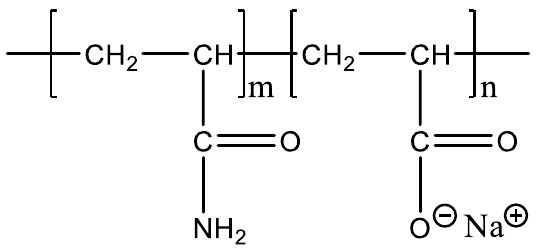
Figure 1. The molecular formula of HPAM.